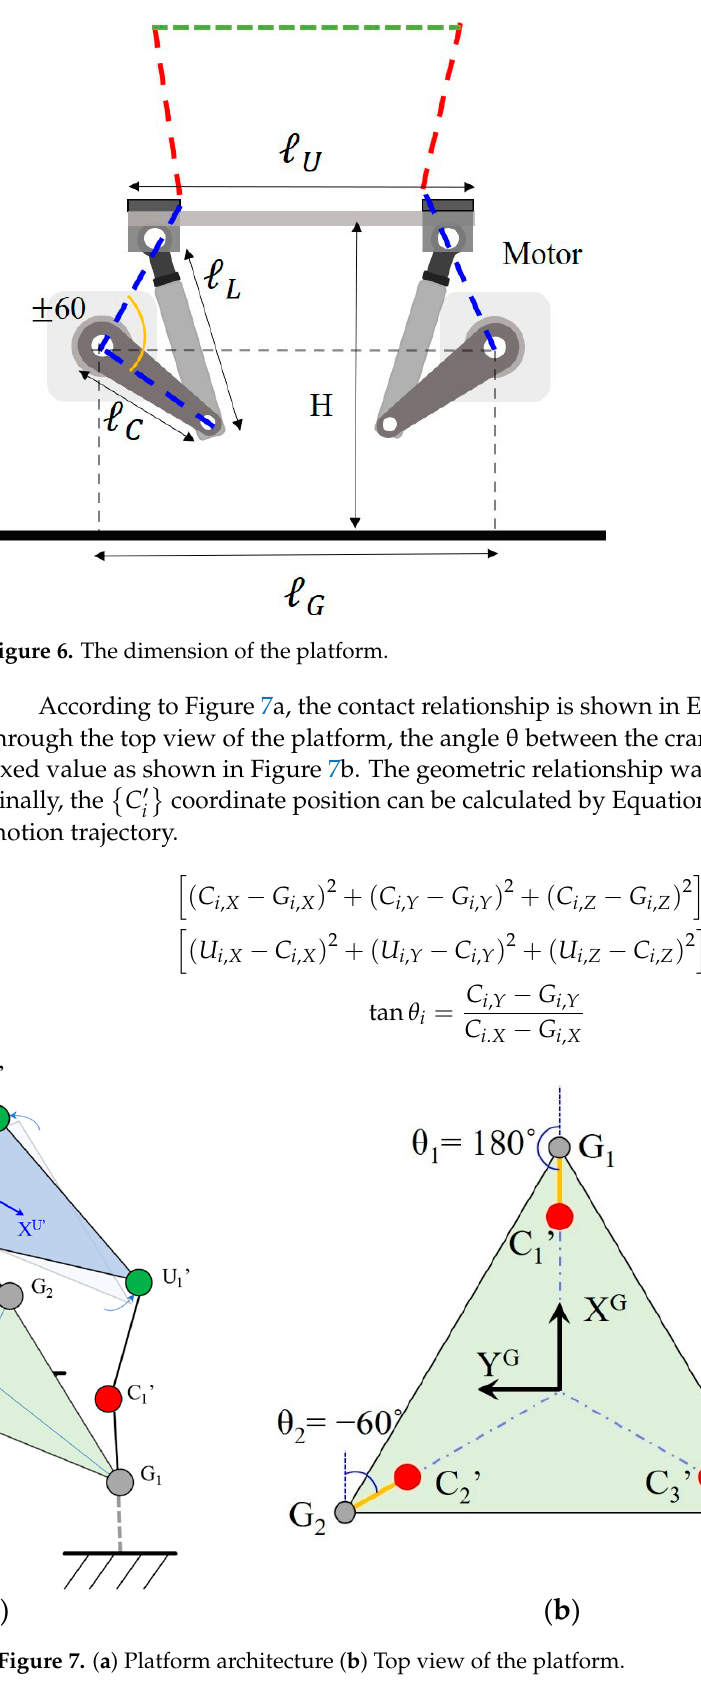
Figure 7. ( a ) Platform architecture ( b ) Top view of the platform.